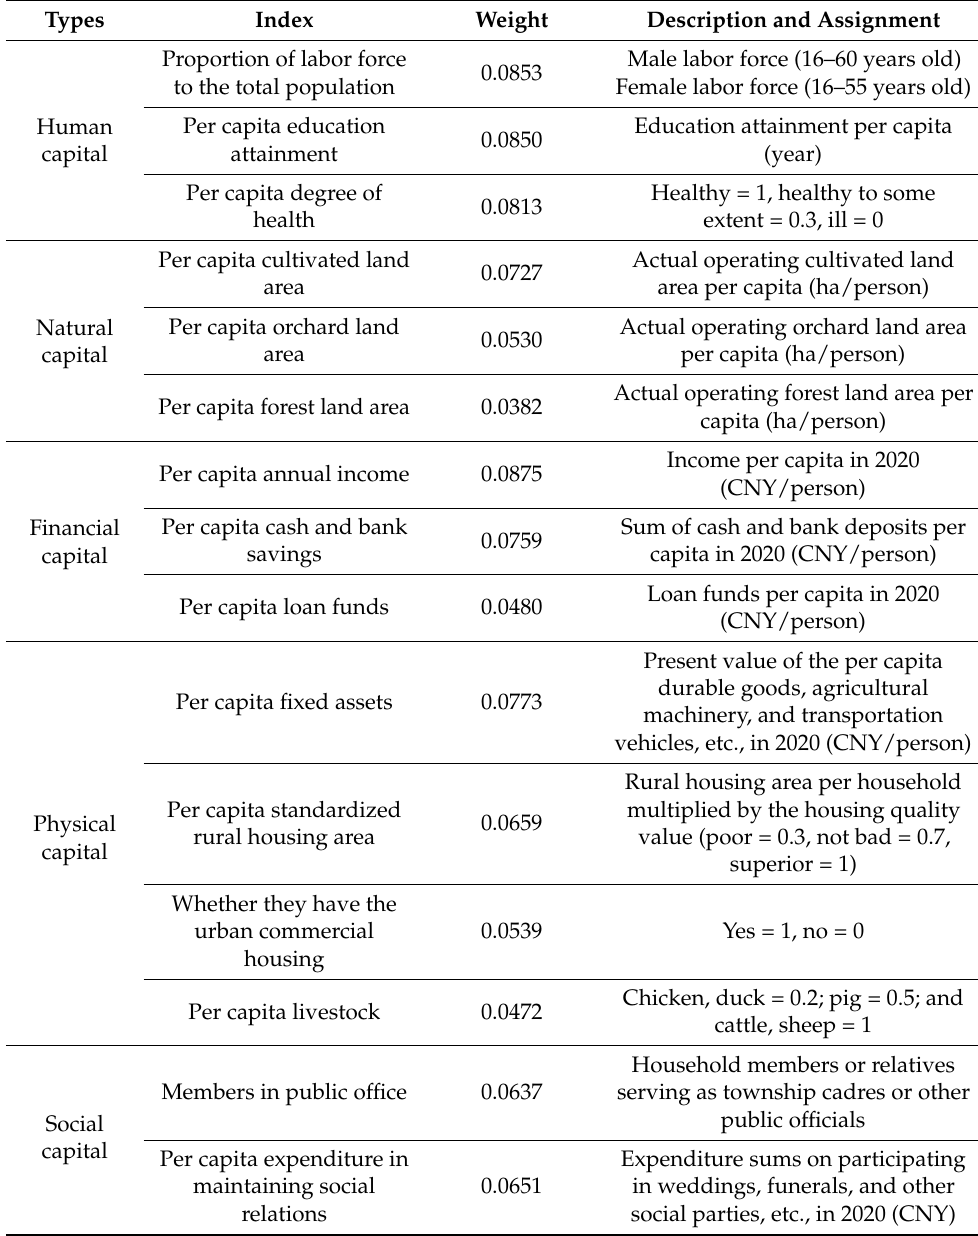
Table 1. Evaluation index system for household livelihood